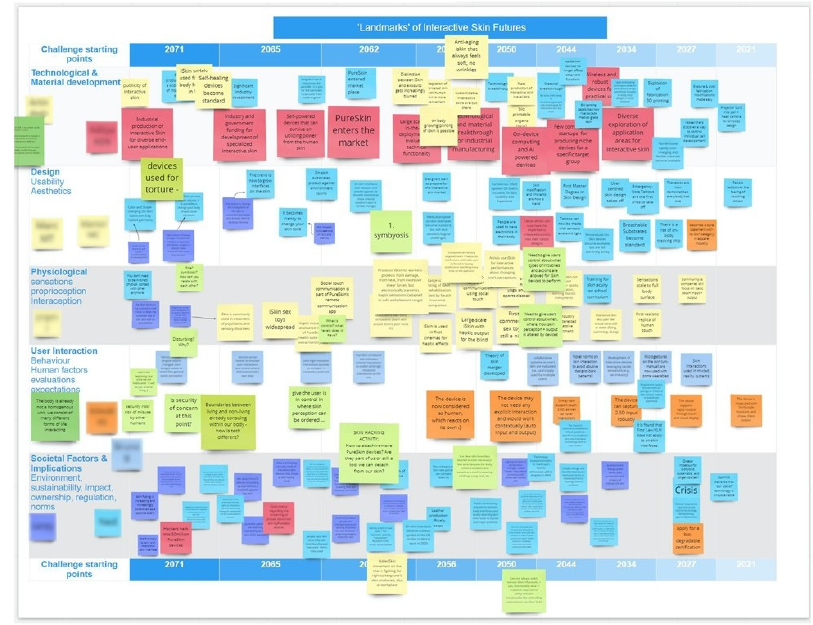
Figure 3. Miro board collective mapping of interactive skin futures.